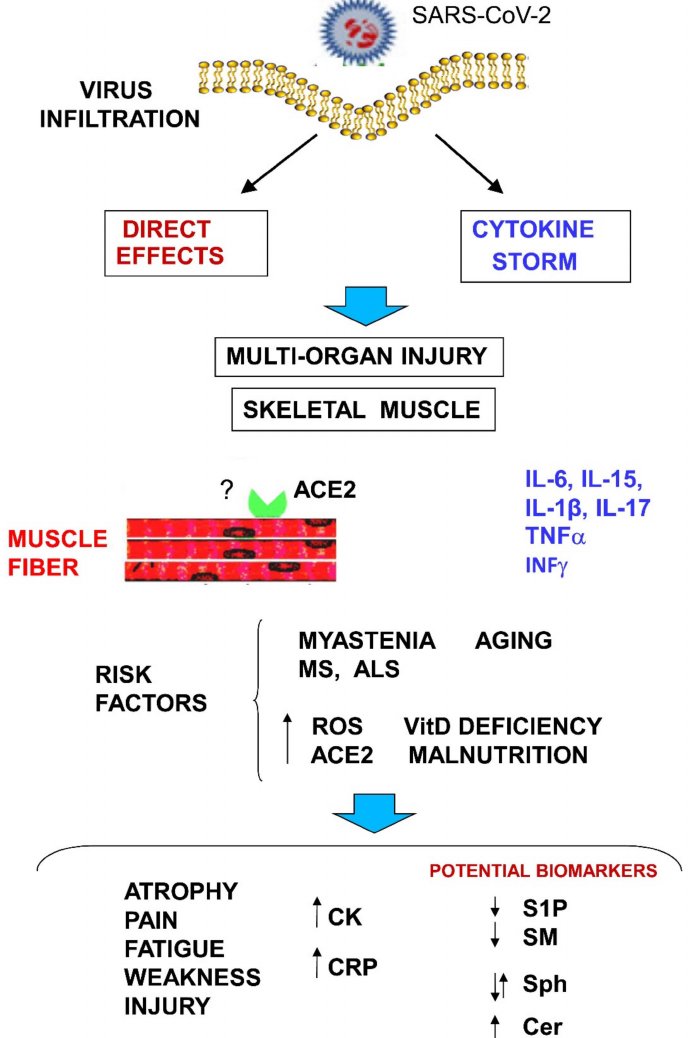
Figure 2. Potential effects, risk factors, and potential biomarkers of SARS-CoV-2 infection into skeletal muscle. Viral infection or cytokine storm can lead to multiorgan injury, including skeletal muscle damage through multiple pathways (see text). Risk factors for developing COVID-19 are